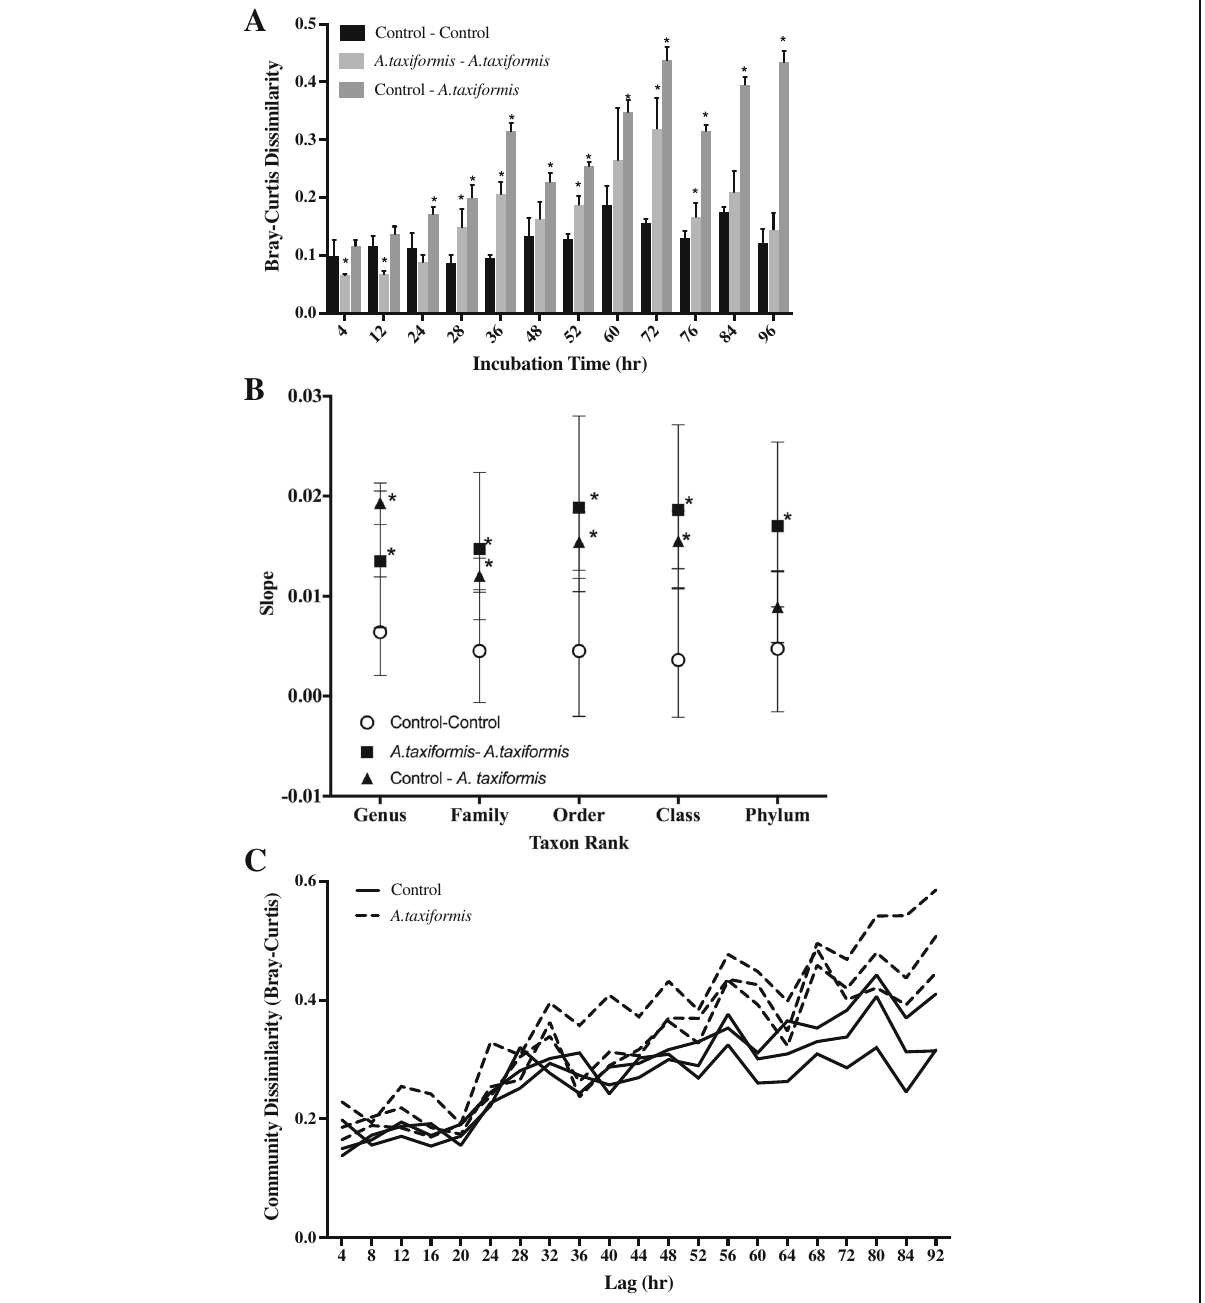
Fig. 4 Effects of seaweed amendments on composition of in-vitro rumen microbiome. a Genus-level β -diversity between pairs of vessels throughout the duration of the experiment. b β -diversity across multiple taxonomic groups measured between pairs of samples versus sampling time for each of the 6 vessels. 95% bootstrap confidence intervals are shown. Regression slopes identified as significant ( p < 0.001) by a permutation test are indicated with an asterisk. c Genus-level β -diversity within individual vessels across different sampling